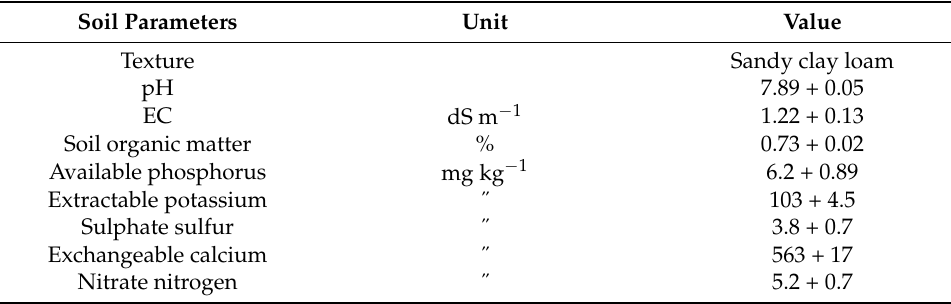
Table 1. Physicochemical characteristics of soil pre-gypsum